Question: Reading the figure, is the described quantity rising or falling?
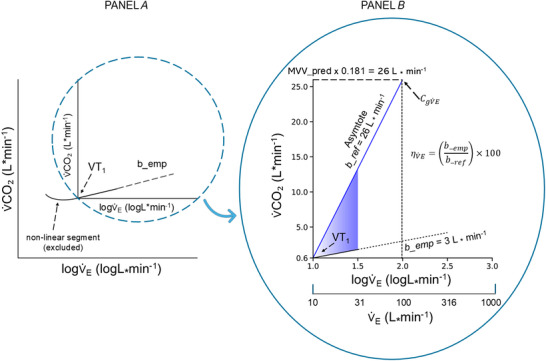
Answer: increasing